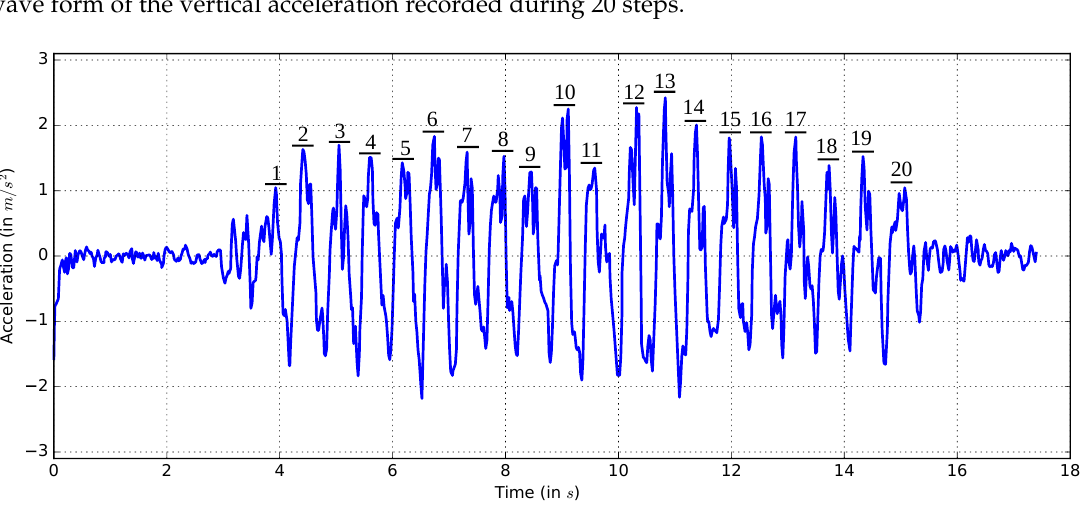
Figure 8. Vertical acceleration record of 20